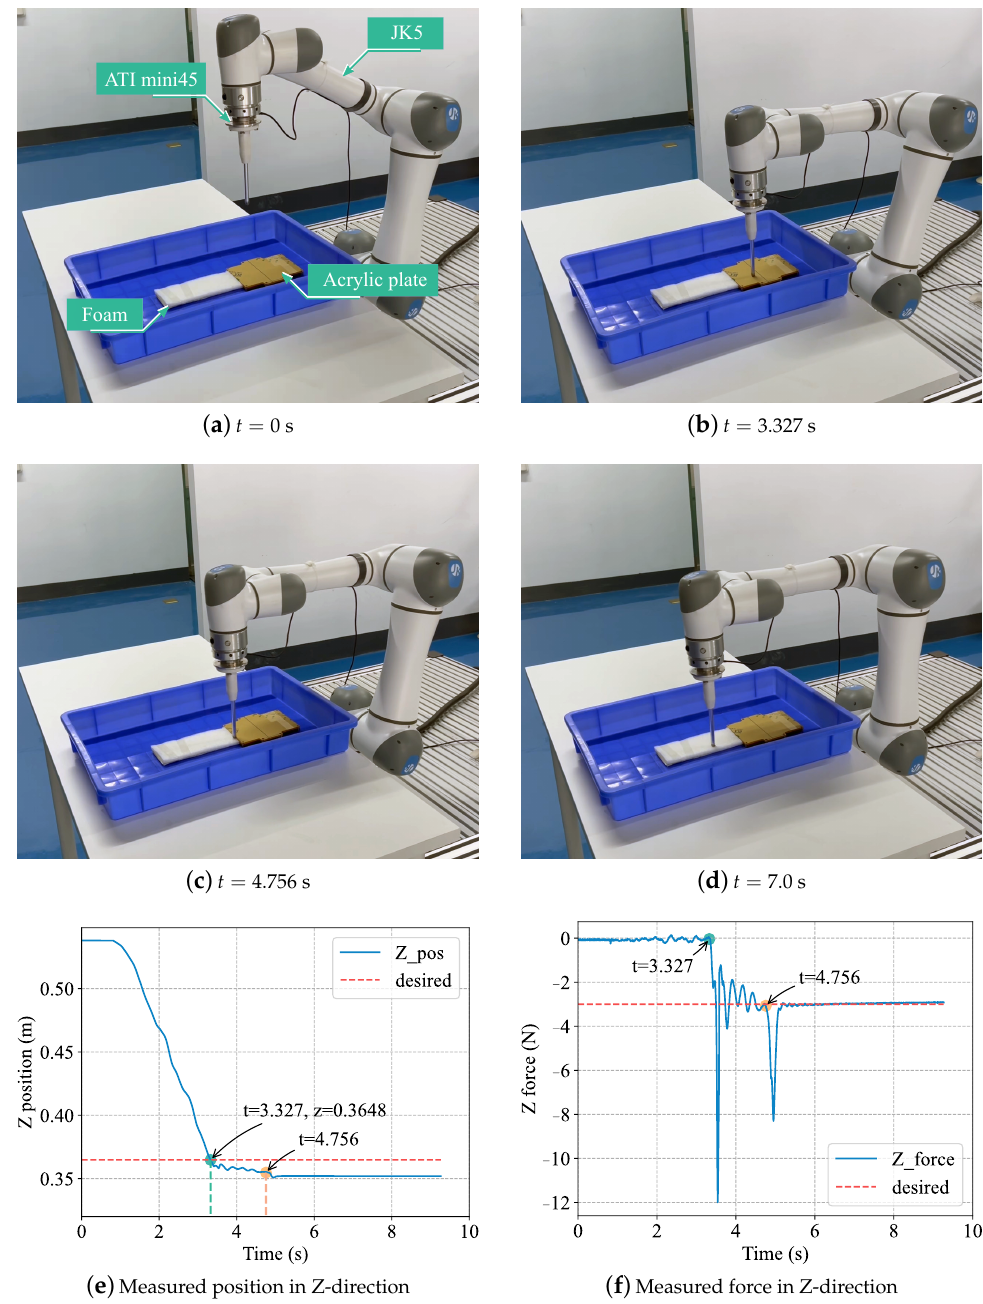
Figure 8. This figure shows the force tracking under unknown environment with the proposed NAIC method: ( a – d ) are the motion of the robot; ( e ) depicts the measured position of EE in Z-direction; ( f ) illustrates the force tracking result. The contact position in the Z-direction is 0.3648 m, and the desired force is − 3